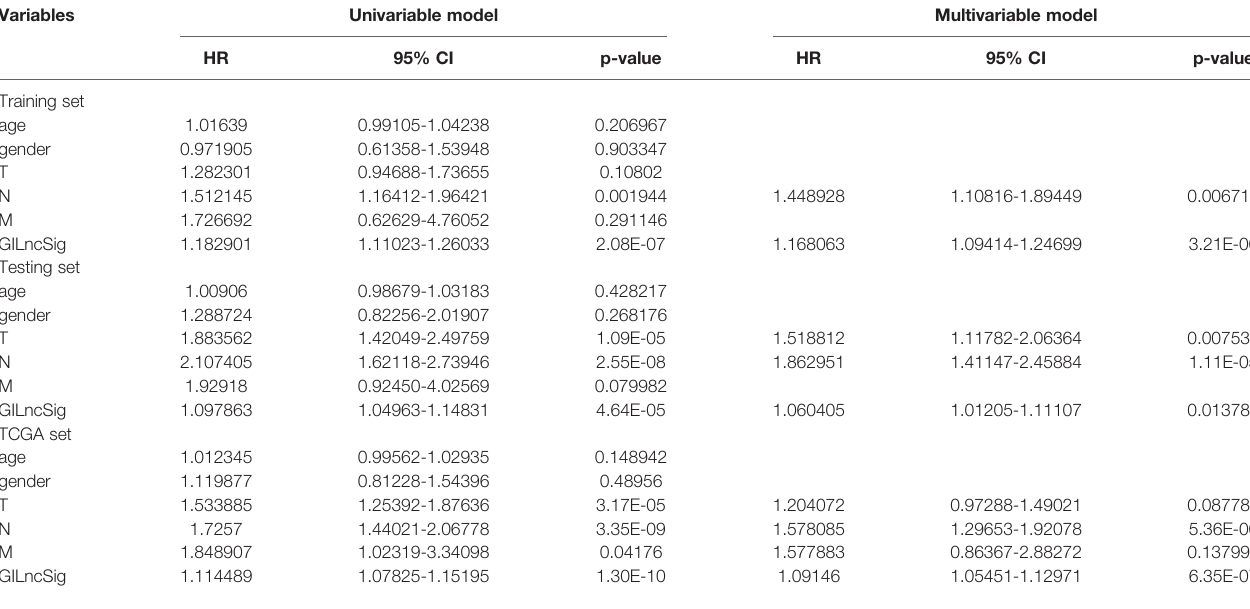
TABLE 4 | Univariate and Multivariate Cox regression analysis of the GILncSig and overall survival in different patient sets.